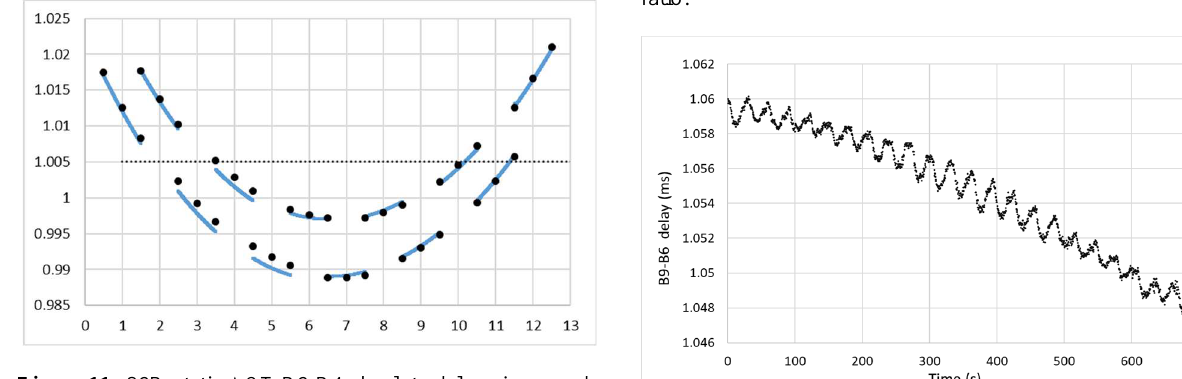
Figure 11 : S2B static ACT B2-B4 absolute delays in seconds function of detector number. Black dots: empirical results (3 pixels per detector). Blue: simulation. Dashed: ESA handbook value.